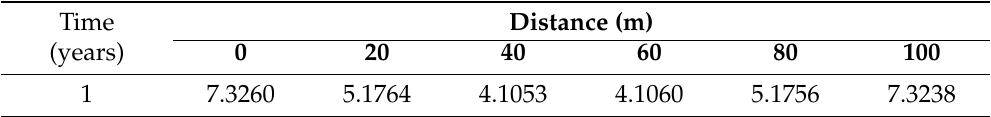
Table 6. Approximated shoreline evolution along one year by Saulyev finite difference